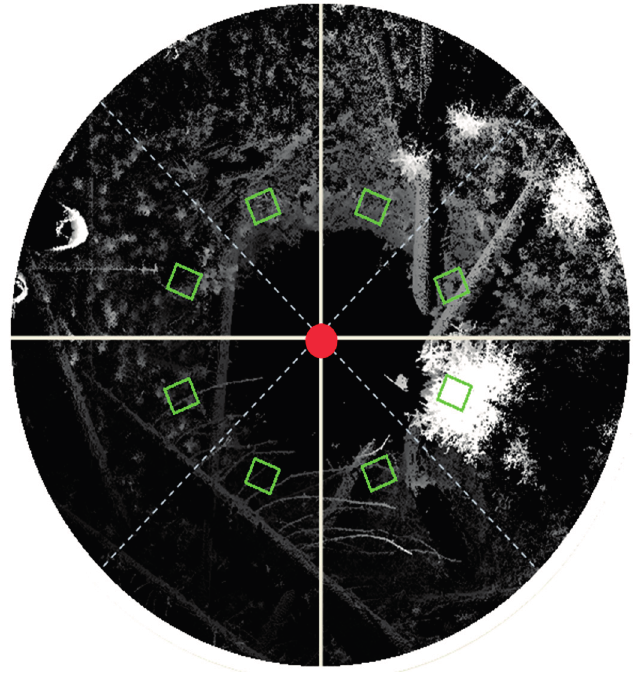
Figure 9. Suggested sampling strategy for linking field measurements of species abundance and richness with vegetation spatial configuration indices (3DI and 3PI). The image is an overhead view of a TLS point cloud, rendered by height with the tallest points white and the lowest points black. Superimposed on the image are the TLS instrument location (red dot), quadrants of the scanning area (delineated by solid lines), vegetation transects (dotted lines), and Daubenmire style vegetation quadrats (green